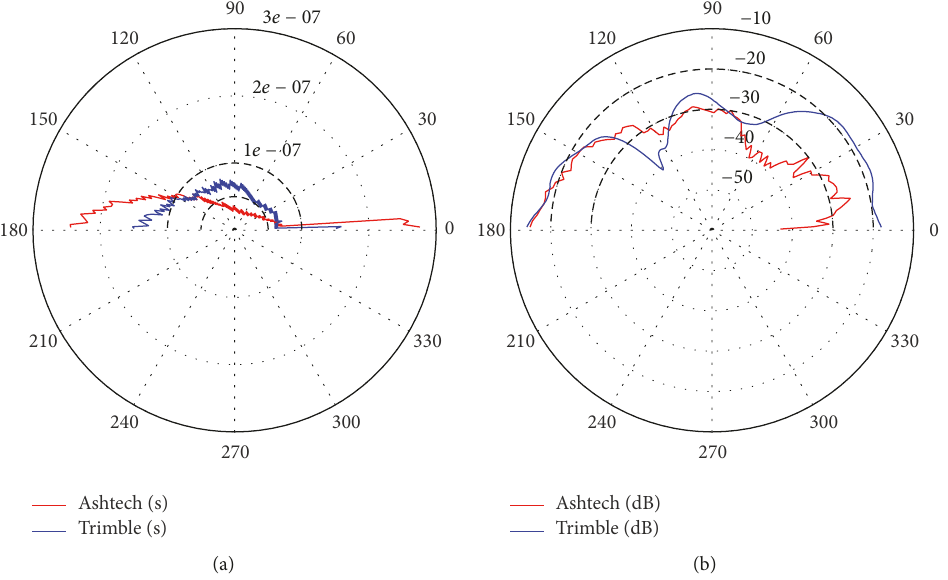
Figure 7: In this figure the relative permittivity 𝜀 2 /𝜀 1 is set experimentally for dry soil surface [19] at 𝜀 2 /𝜀 1 = 3 . Error tolerance of PPE is set to 0.05𝑇 𝑐 and 0.1𝑇 𝑐 . (a) is the result of proposed assessment method. (b) is the front-to-rear ratio approach. Black dotted circles in (a) are tolerance